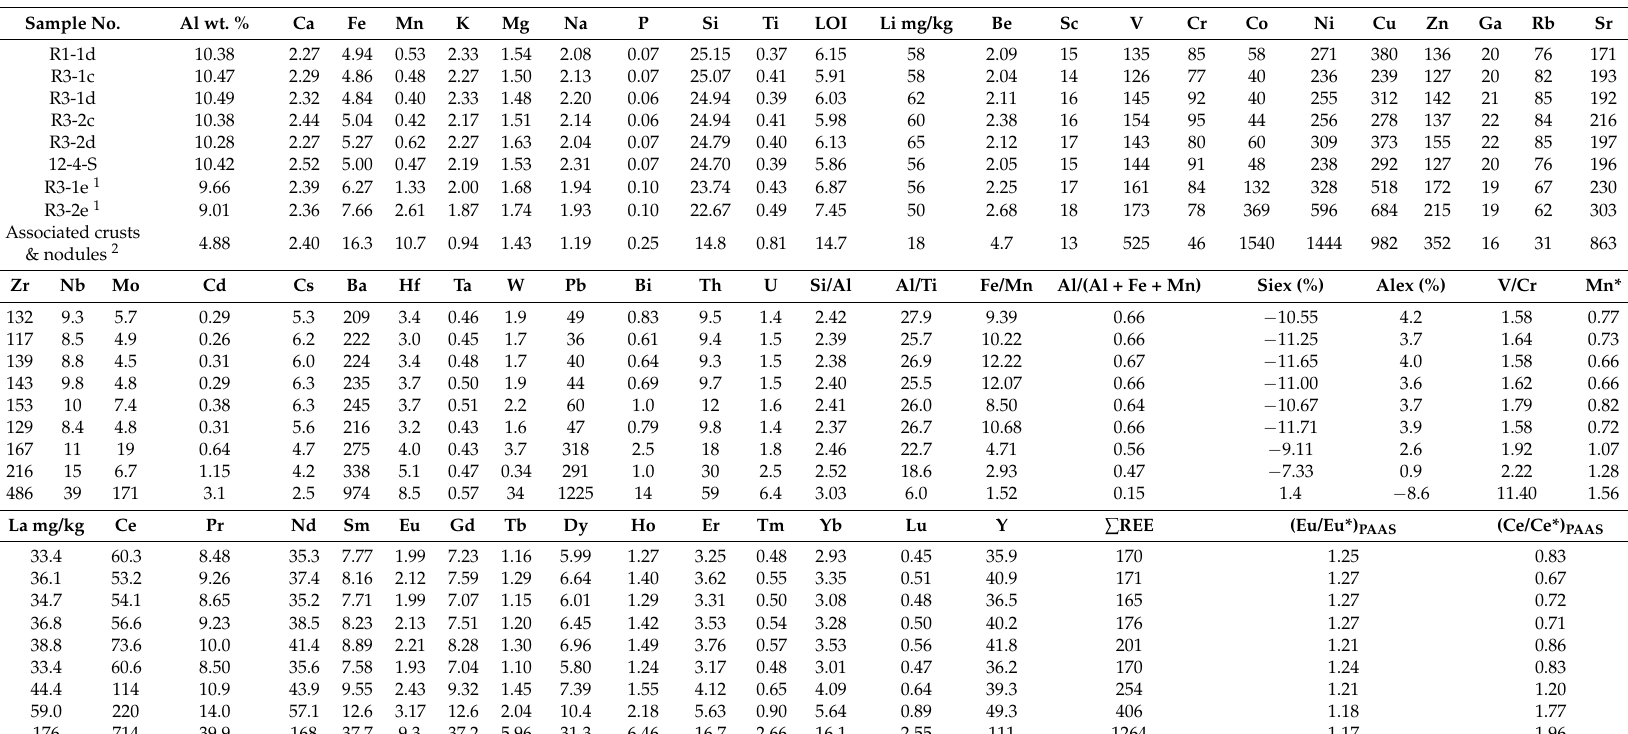
Table 1. Major element (wt. %) and trace element (mg/kg) data of sediment samples in the eastern flank of the Gagua Ridge. Data of associated crust & nodule samples are also